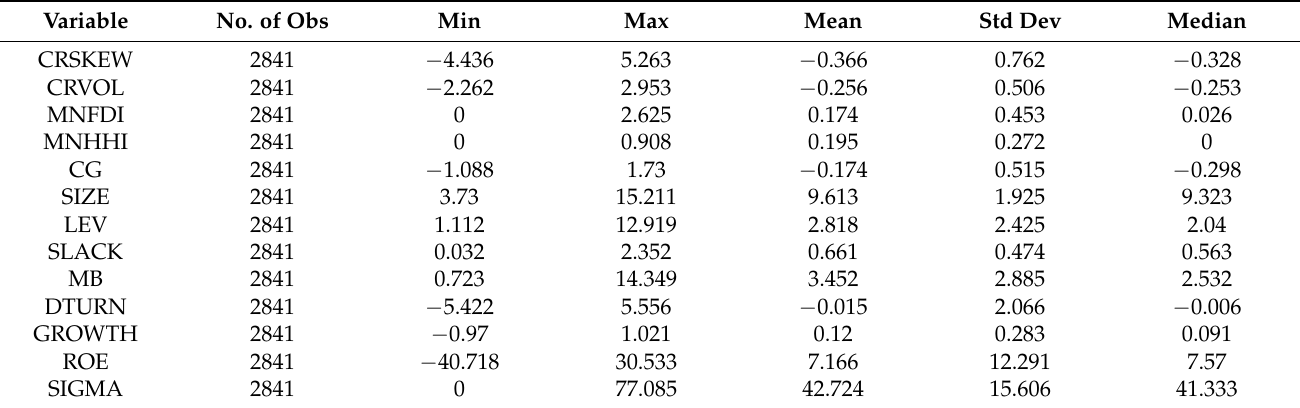
Table 2. Descriptive Statistics.